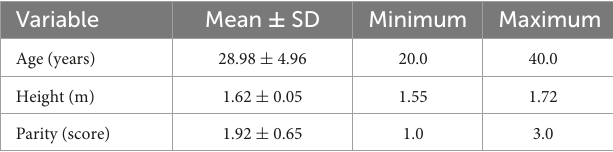
TABLE 1 Participants’ baseline